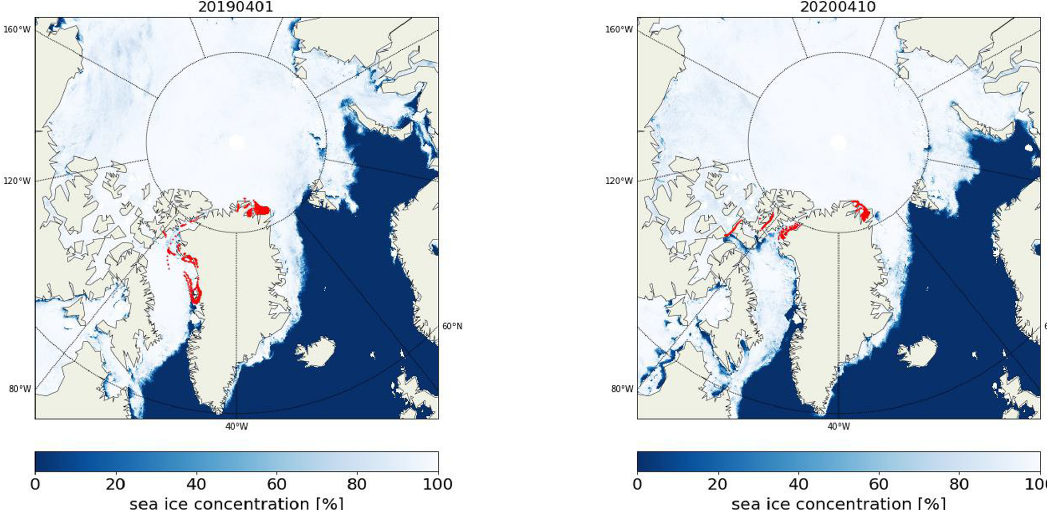
Figure 9. Shown in red are 5d back trajectories (50ma.g.l. arrival height at VRS) for times when they were below 250m. The two panels correspond to sampling times of two filters, for which the sampling end dates were 1 April 2019 and 10 April 2020. Averaged sea-ice concentrations during the sampling periods are also